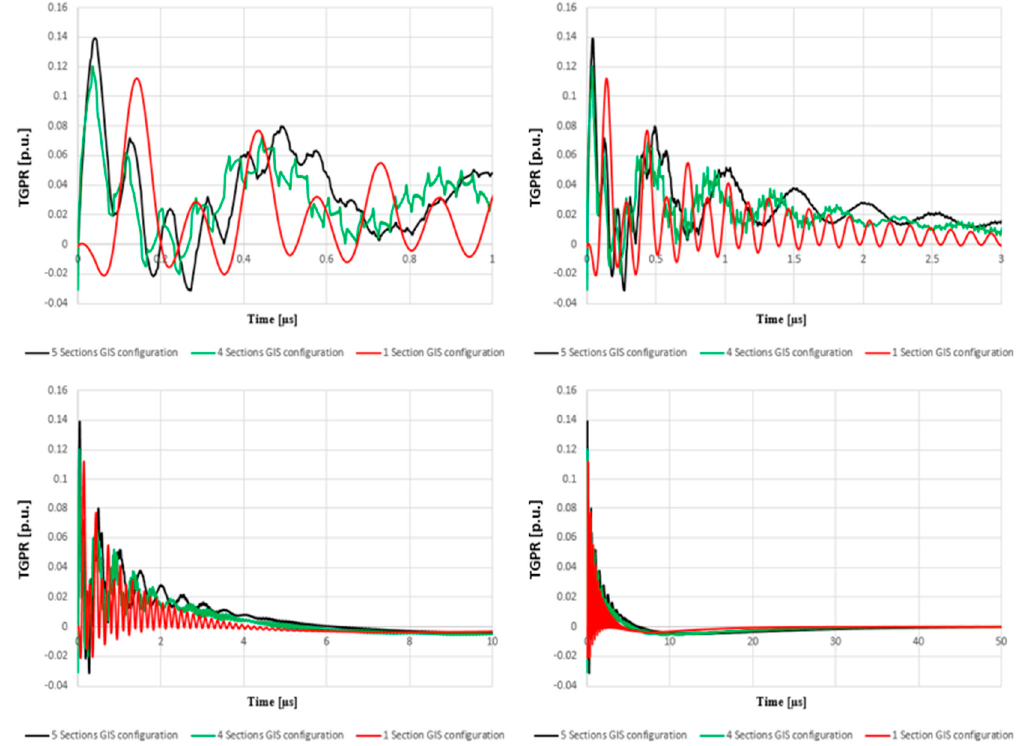
Figure 9. Transient ground potential rise on the upper side of metallic enclosure (BUS4).